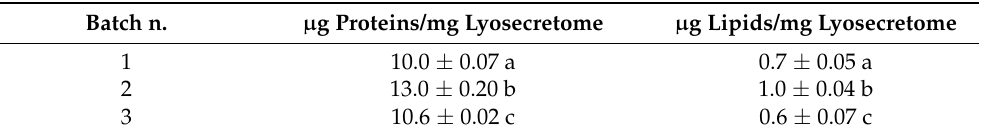
Table 4. Lyosecretome total protein and lipid content; mean values ± standard deviation, n = 3. Different letters indicate a significant difference between groups ( p < 0.0001).